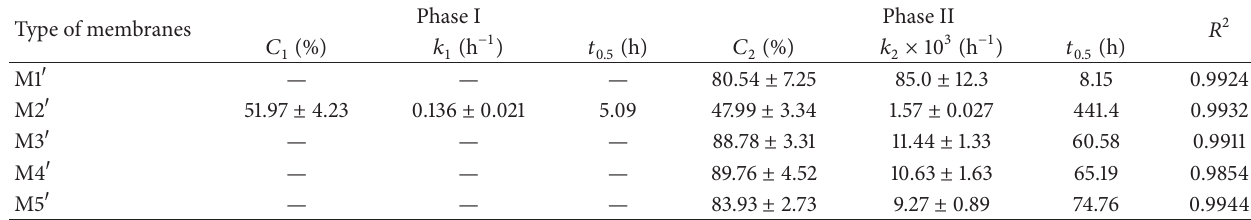
Table 4: Constant values of kinetic equation describing in vitro amoxicillin release from the membranes, mean ± SD. Type of membranes